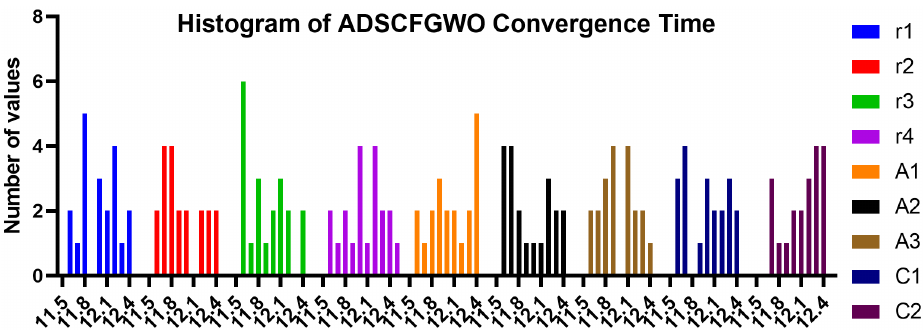
Figure 10. Histogram of convergence time of ADSCFGWO’s parameters ( r 1 , r 2 , r 3 , r 4 , A 1 , A 2 , A 3 , C 1 , and C 2